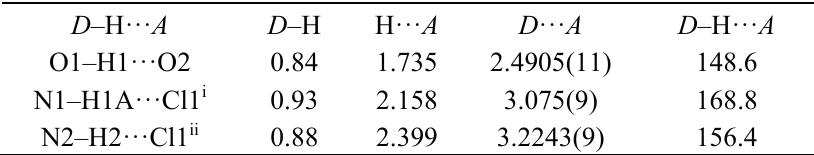
Table 7. Hydrogen-bond geometry (Å, °) for 14